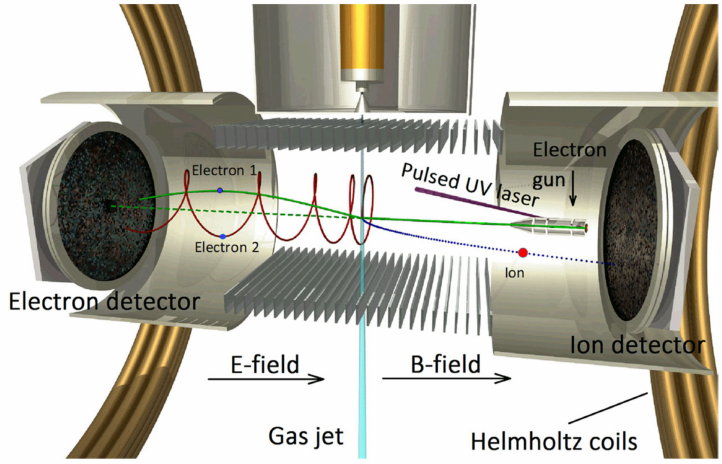
Figure 6. Schematic diagram of the reaction microscope used to analyze the angular and energy resolved double and triple differential cross sections, for electron induced ion fragmentation to benzene